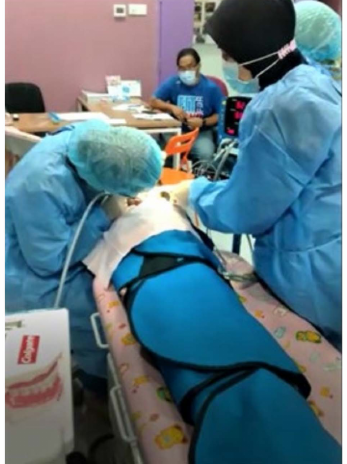
Figure 1. The subject child was wrapped with Olympic Papoose Board ® (Olympic Papoose Board, Natus Medical Incorporated, Pleasanton, CA, USA) during dental treatment. Workflow for AB/BA